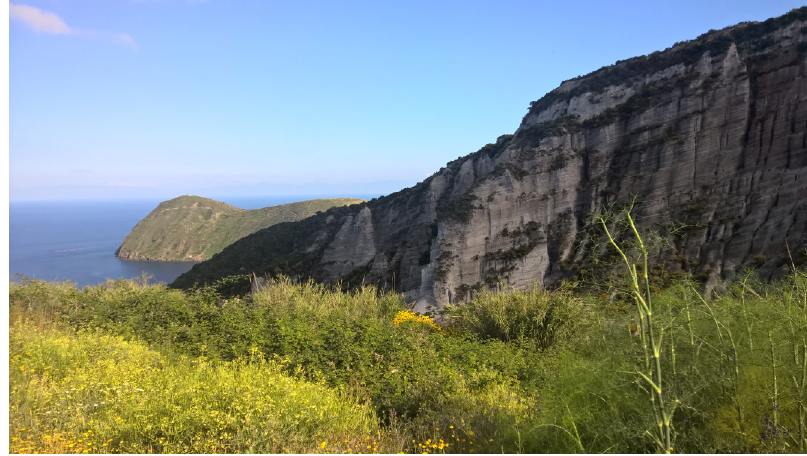
Figure 3. Picture of Gabellotto Gorge from the northwest. Monte Rosa in the